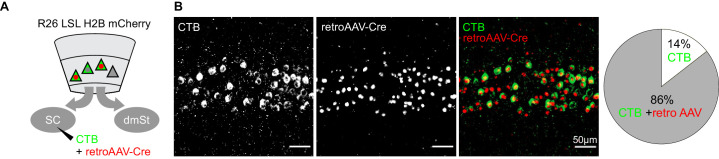
Comparing CTB with retroAAV for retrograde labeling.(A) Schematic illustration of viral efficiency test. Co-injection of CTB Alexa 488 and retroAAV-Cre in R26 LSL H2B mCherry mice. Uptake of retroAAV-Cre leads to the expression of mCherry in the nucleus. (B) Left: Maximum intensity projection of the confocal stack of a coronal section through layer 5 of primary visual cortex. Right: Proportion of CTB-labeled cells in L5 that co-express nuclear mCherry. Note that the majority of CTB-labeled cells is also expressing nuclear mCherry. The majority of CTB-labeled cells co-expressed nuclear mCherry, indicating that the viral approach was highly efficient in retrogradely labeling cortico-fugal neurons.